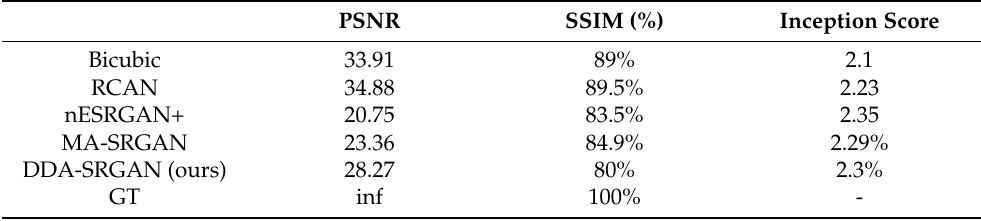
Table 6. The comparison of the proposed method with different SR models for iris recognition.